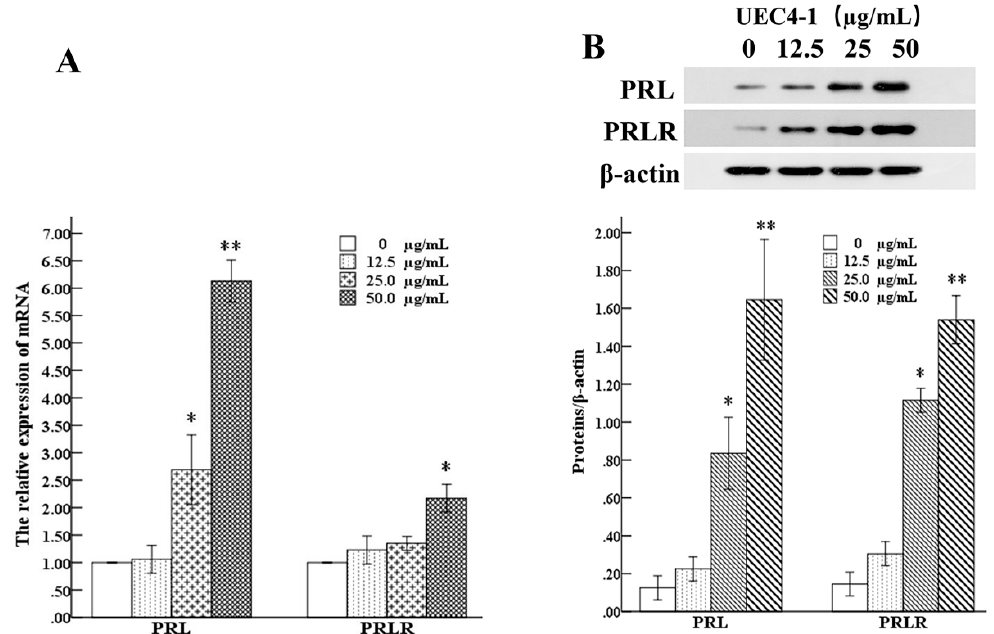
Figure 8. Effects of UEC4-1 on PRL and PRLR expression. ( A ) The expression of PRL and PRLR in mammary gland; ( B ) The protein levels of PRL and PRLR in mammary gland. * significantly different from the control group at p < 0.05, ** significantly different from the control group at p < 0.01.